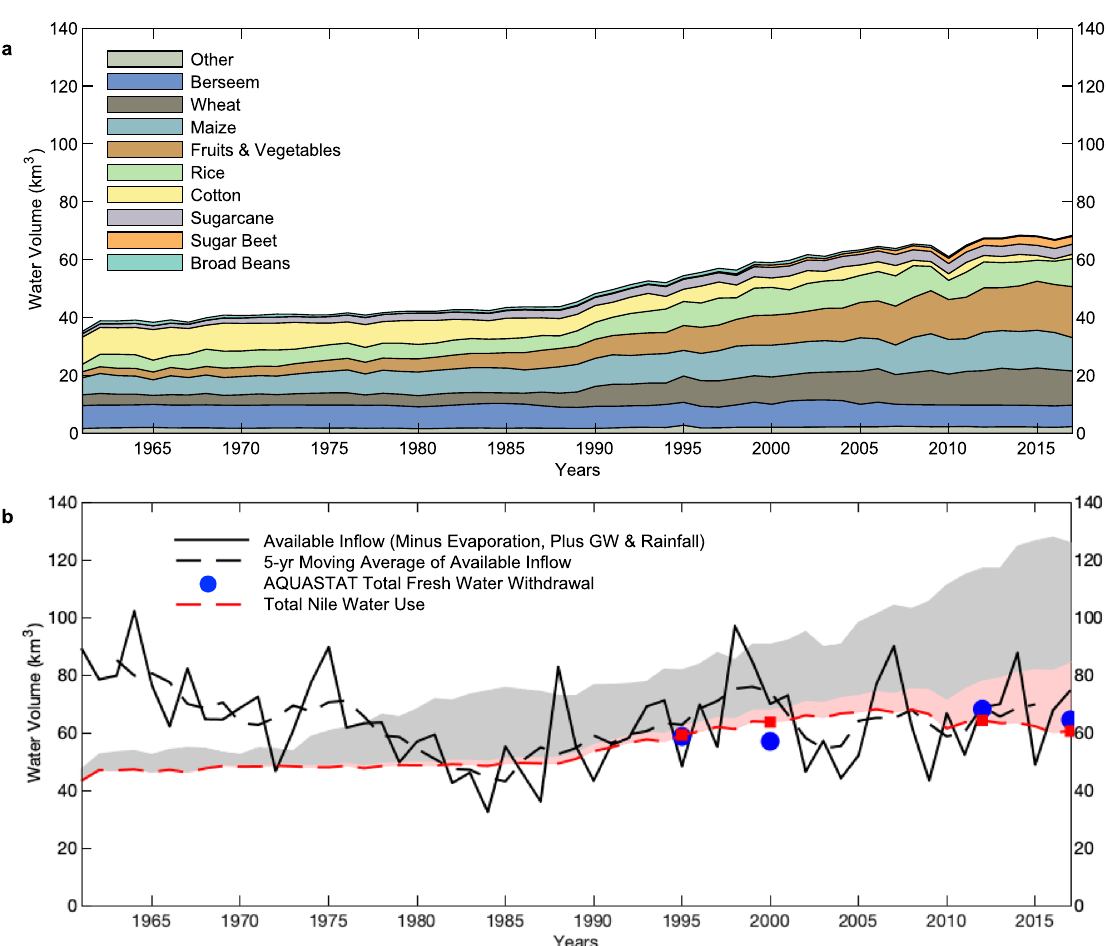
Fig. 3 Bottom-up estimates of historical use. a Historical water application in Egypt for agriculture broken down by crop (Supplementary Tables 1.1, 1.2, and 1.7). b Historical total Nile water use (agriculture + municipal + industrial − reuse) [red dotted line] compared to available supply [black lines]. Red squares mark values for 1995, 2000, 2012, and 2017. This is the fl ow at Dongola station adjusted by evaporation at Lake Nasser and from other surface water bodies (estimated at 10 km 3 and 2 km 3 respectively) 2 , with added rainfall and primary groundwater abstraction (1.5 km 3 and 0.5 km 3 respectively) 12, 52 . Storage change in Lake Nasser is not considered in this availability estimate. These are compared to the AQUASTAT numbers for freshwater withdrawal in Egypt [blue dots] 46 (Supplementary Table 1.16). Dark Gray shading represents the amount of Virtual Water Import (shown in Fig. 2e), and light red shading shows the amount of drainage, wastewater reuse, and GW reuse (shown in Fig. 2c). These shaded areas represent the additional demand met by these sources, and not a range of